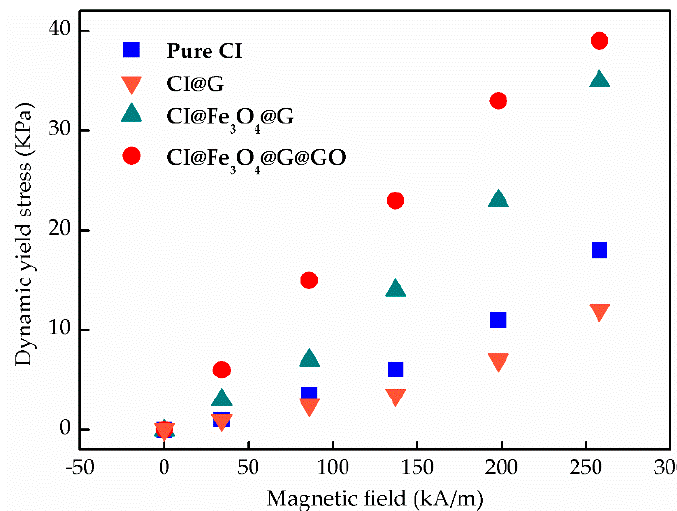
Figure 9. Plots of dynamic yield stress vs. magnetic field of MR fluids based on pure CI, CI@G, CI@Fe 3 O 4 @G and CI@Fe 3 O 4 @G@GO particles.